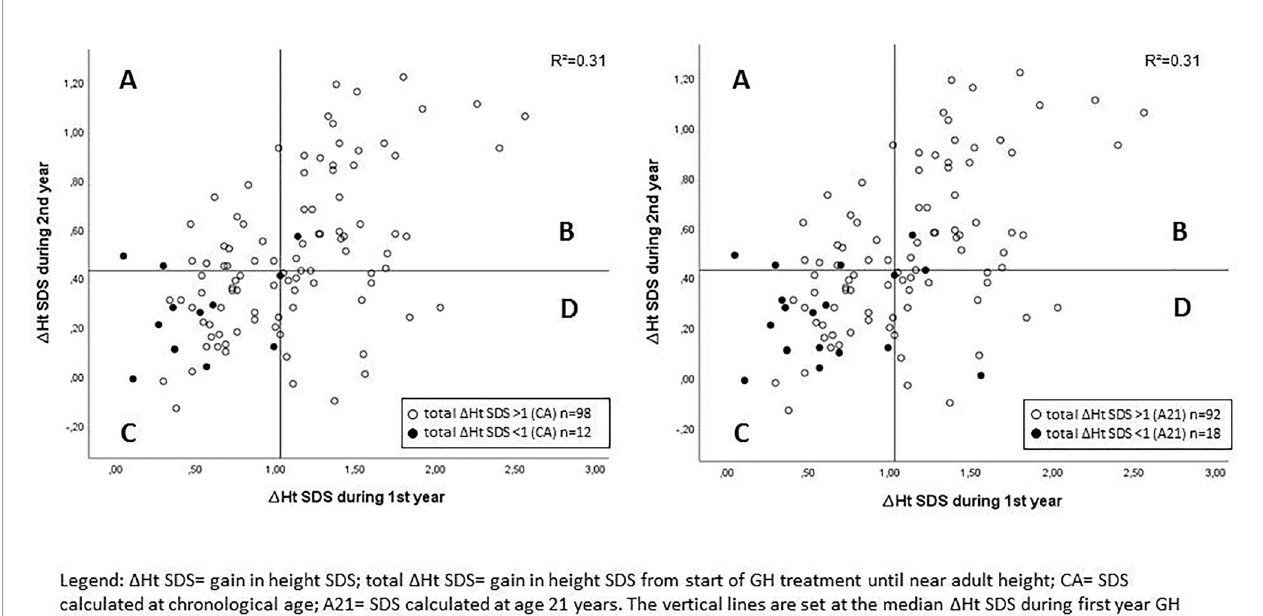
FIGURE 1 | Correlation between D height SDS during the fi rst and second GH treatment years with indication of poor fi nal responders. A: lower than median D Ht SDS during 1st year and higher than median D Ht SDS during 2nd year; B: higher than median D Ht SDS during 1st year and higher than median D Ht SDS during